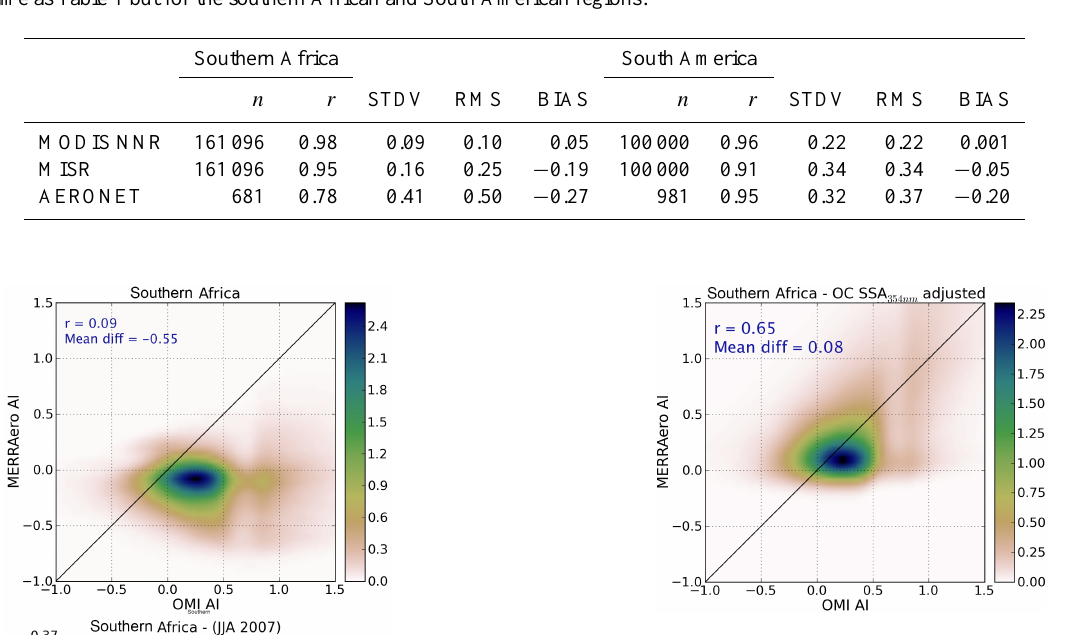
Figure 13. Comparison of AI for JJA 2007 over the southern African region after decreasing the SSA at 354nm for the organic component of biomass burning by